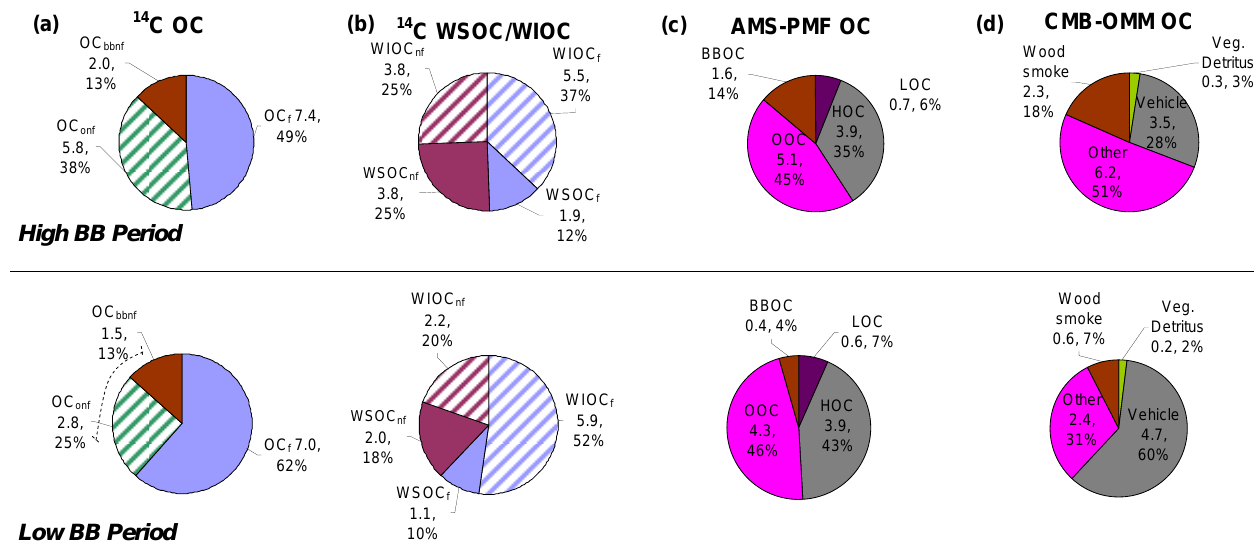
Fig. 12. Apportionment of OC (µgCam − 3 ) for periods within the high fire (filters 1, 2) and low fire (filters 3, 4) periods for (a) fossil (OC f ) and non-fossil (biomass burning OC bbnf , other non-fossil OC onf ) fractions with dashed lines representing the uncertainty arising from the variability in (OC/EC)bb in the literature, (b) fossil and non-fossil WSOC and WIOC fractions, (c) AMS-PMF sources, and (d) CMB-OMM